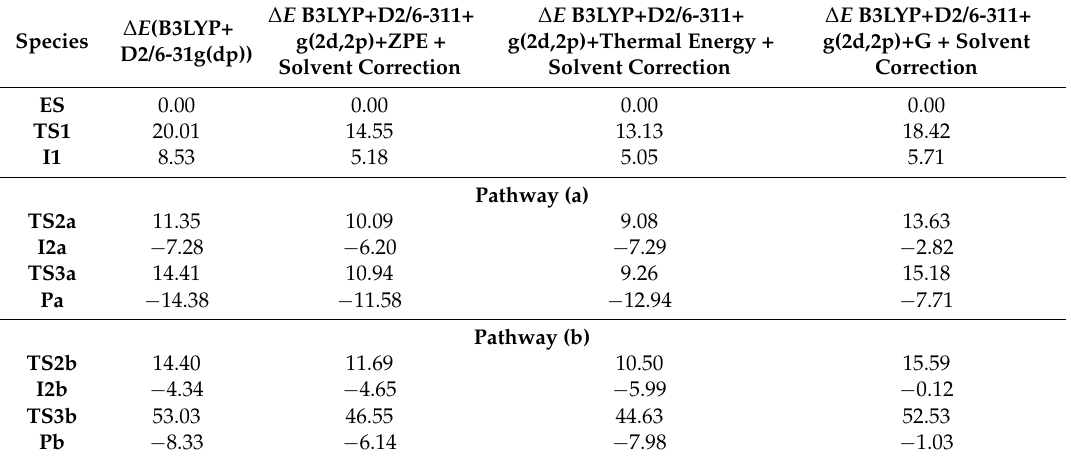
Table 1. The energy profile (in kcal/mol) obtained for cluster modeling of pathway ( a ) and ( b ) (pro( R )). Two variants of the benzyl radical attack on the fumarate are considered ( a ) the attack on the distal carbon atom and ( b ) the attack on the proximal one (with respect to the Cys493). All energy differences were calculated with respect to ES